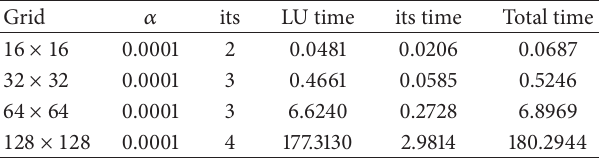
Table 10: Preconditioned GMRES(20) on steady Oseen problems with different grid sizes (uniform grids), viscosity V = 0.1 .